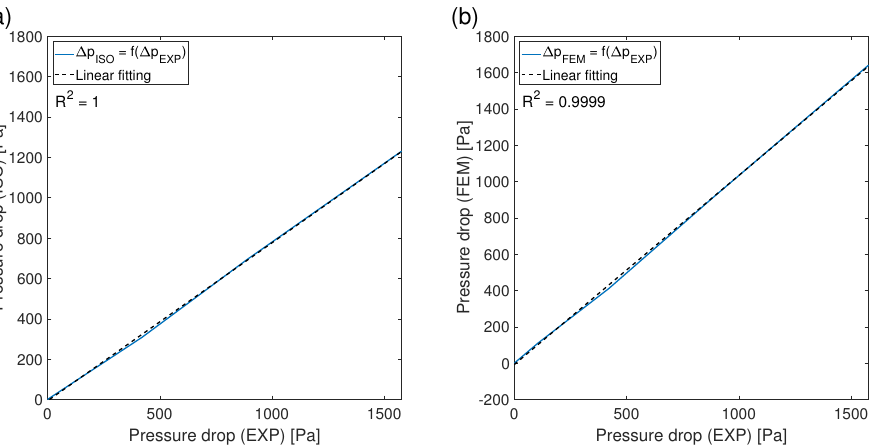
Figure 9. Coefficient of determination R 2 between ( a ) analytical (ISO) and experimental results and ( b ) numerical and experimental results for the configuration of splitter silencers with semihexadecagonal